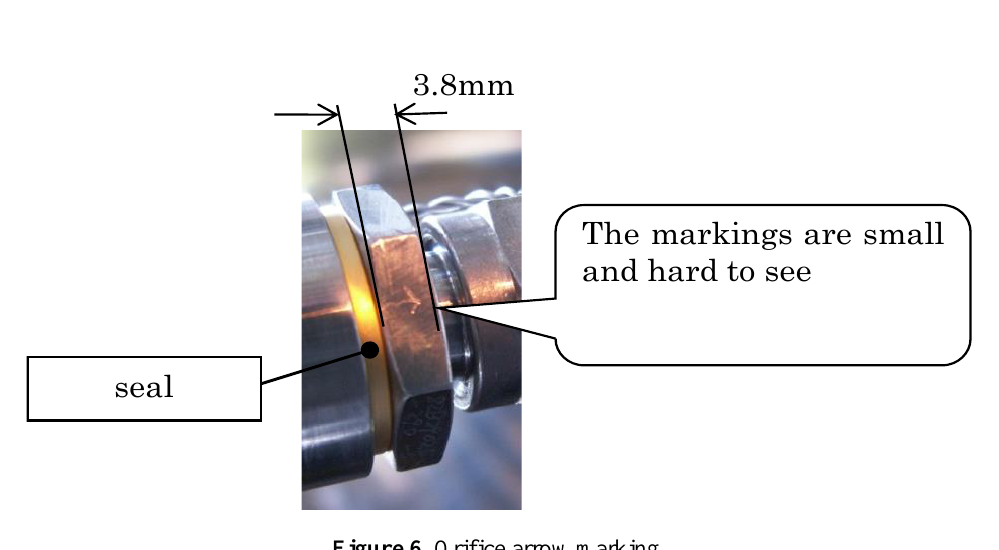
Figure 6. Orifice arrow marking.